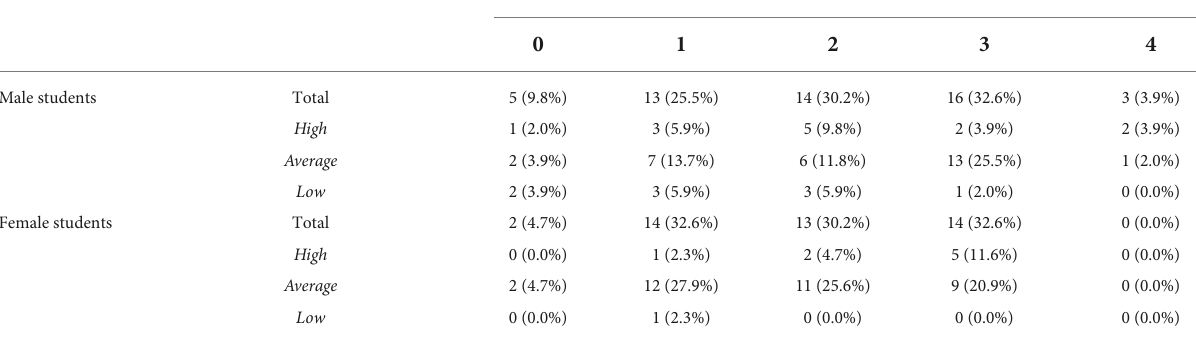
TABLE 5 Students’ achievement level and the number of correct answers on the two tests.